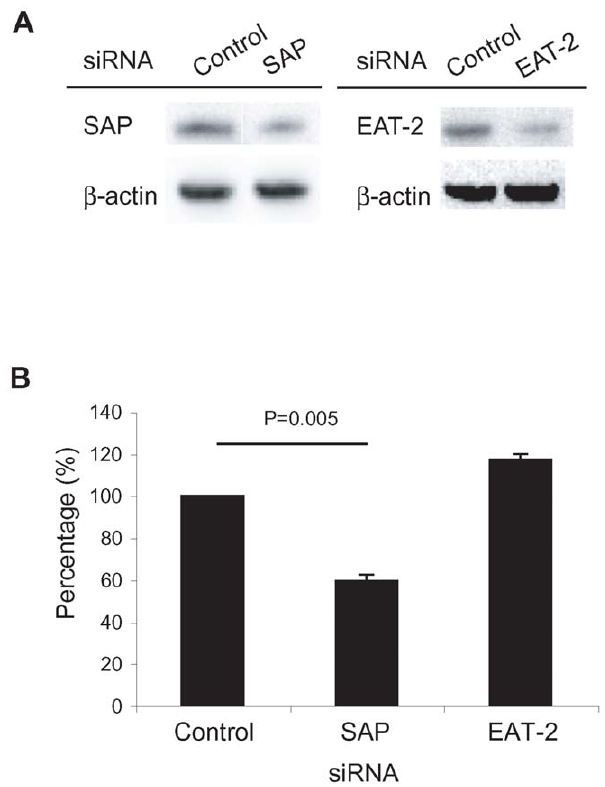
Figure 6. Inhibition of degranulation and IFN- c expression in CD8 + T cells of patients with HAM/TSP by SAP siRNA. (A) SAP and EAT-2 expression in transfected CD8 + T cells with either control, SAP or EAT-2 siRNA was determined after the culture for 6 hours. The cell lysates were prepared from transfected CD8 + T cells, and each 10 m g of the cell lysates was loaded on the gel. (B) Inhibitory effects of SAP or EAT-2 siRNA on degranulation and IFN- c expression in transfected CD8 + T cells. Isolated CD8 + T cells from patients with HAM/TSP were transfected with control, SAP or EAT-2 siRNA, and then cocultured with autologous CD14 + cells. The amounts of CD107a/IFN- c expressions in CD8 + T cells transfected with control siRNA were normalized to 100%, and then, those in CD8 + T cells transfected with SAP or EAT-2 siRNA were calculated. The graph was prepared from data obtained from three patients with HAM/TSP. Error bars represent